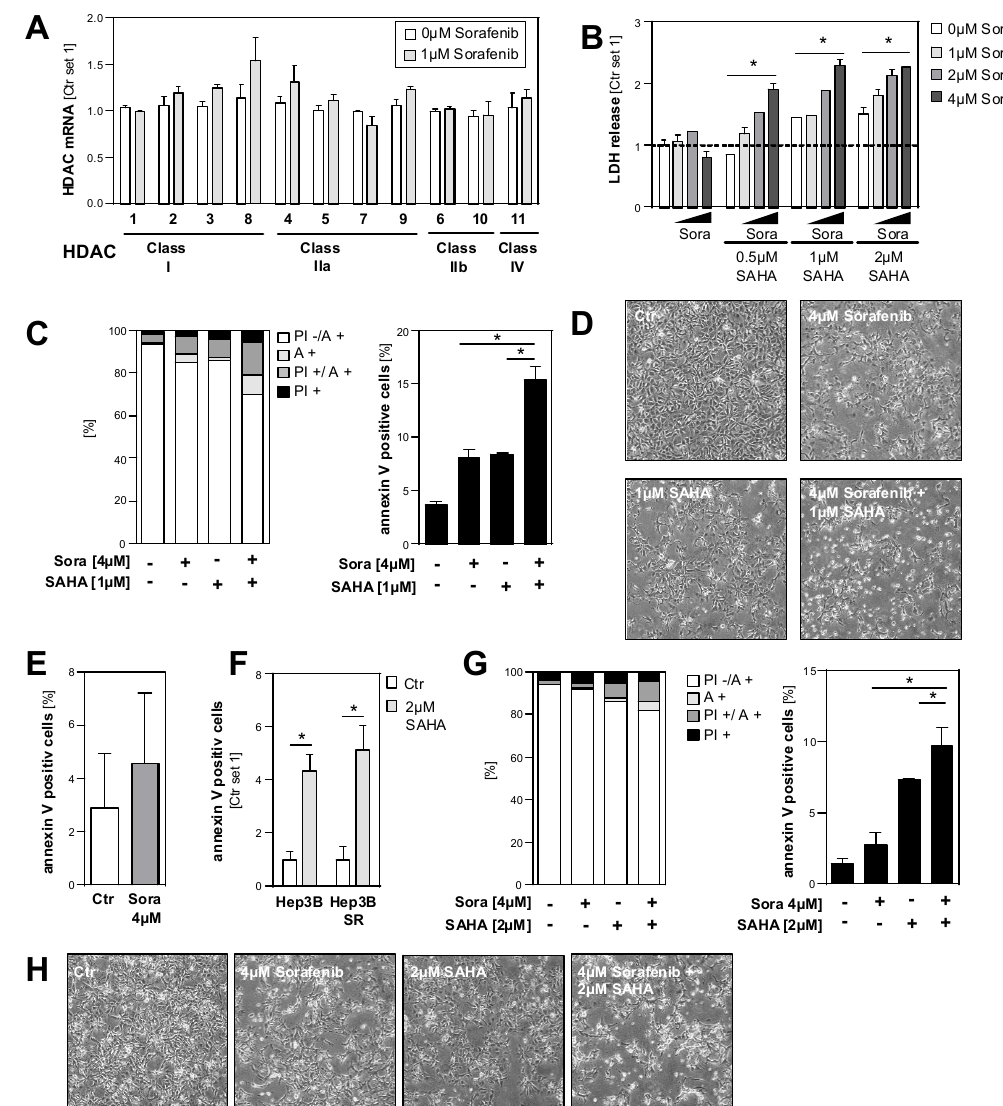
Figure 7. Effects of HDAC inhibition on HCC cells in combination with sorafenib. ( A ) The expression of different HDACs in HCC cells (Hep3B cells) after 24 h treatment with sorafenib (1 µM) or in control cells (Ctr.) treated with solvent (DMSO) only (set as 1). ( B ) Quantification of LDH release into the supernatants of HCC cells after 72 h treatment with sorafenib (Sora) and/or SAHA (Ctr. set 1). (C) Propidium iodide/annexin (PI/A) fluorescence-activated cell sorting (FACS) analysis of HCC cells after 72 h treatment with sorafenib (Sora) and/or SAHA (Ctr. set at a value of 1). Left panel: proportions of viable (PI -/ A -), early (A +) and late apoptotic (PI +/ A +) and necrotic cells (PI +); right panel: quantification of annexin-positive late apoptotic cells. ( D ) Representative microscopical images of HCC cells after 72 h treatment with sorafenib and/or SAHA. ( E , F ) Propidium iodide/annexin FACS analysis of (resistant) Hep3B cells and sorafenib-resistant Hep3B cells (Hep3B-SR) after 72 h treatment with sorafenib (Sora) (4µM; left panel) or SAHA (2 µM); quantification of annexin-positive cells. (Ctr. set 1). ( G ) Propidium iodide/annexin (PI/A) FACS analysis of Hep3B-SR cells after 72 h treatment with sorafenib (Sora) and/or SAHA. Left panel: proportions of viable (PI -/A -), early (A +) and late apoptotic (PI +/A +) and necrotic cells (PI +); right panel: quantification of annexin-positive late apoptotic cells. ( H ) Representative microscopical images of Hep3B-SR cells after 72 h treatment with sorafenib and / or SAHA. (*: p <